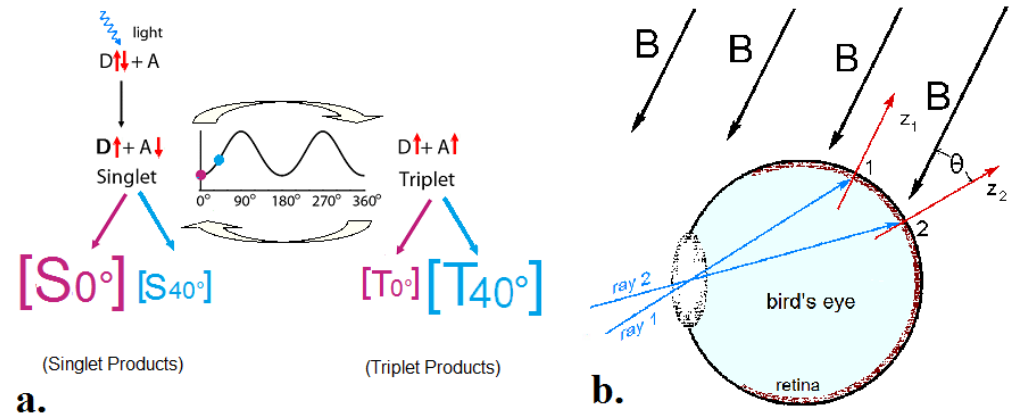
Figure 5. The Radical Pair Model of magnetoreception. ( a ) Scheme of the radical pair mechanisms proposed by Ritz and colleagues [35]. After photon absorption, a radical pair is generated by an electron transfer from a donor (D) to an acceptor (A), with the ratio singlet/triplet depending on the alignment of the molecule in the external magnetic field. The red arrows represent the spins of the electrons. The changing singlet/triplet ratio as a function of the alignment is indicated in the inner diagram; note that 0° = 180° and 90° = 270°. The amount of singlet and triplet products is symbolized for a parallel alignment and a 40° alignment. ( b ) Light rays are projected onto the retina, activating receptor cells that are aligned at different angles with respect to the direction of the magnetic vector B (from [33],